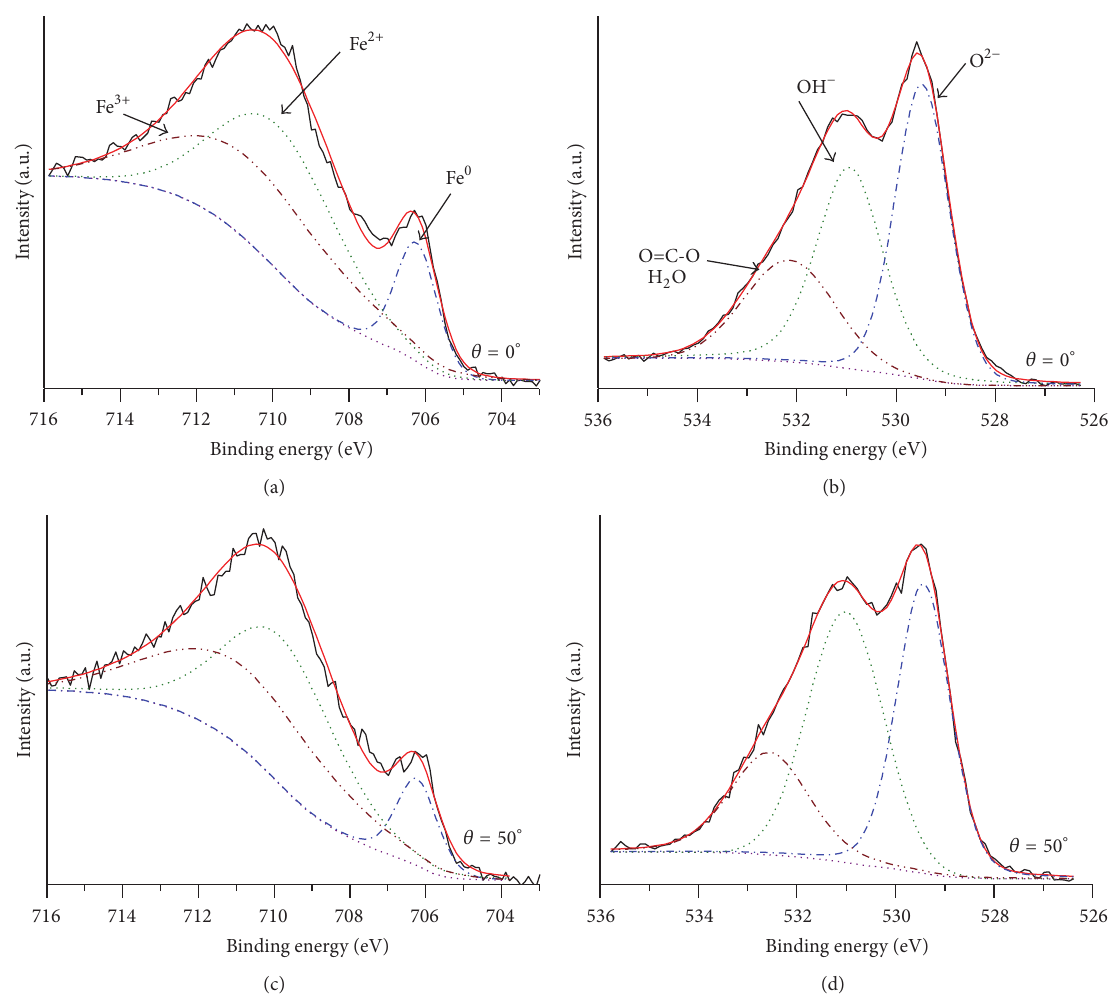
Figure 11: High resolution Fe 2p 3/2 and O 1s spectra for carbon steel after 2h immersion in 0.02 M NaCl containing 0.1M Na-glutarate; spectra obtained at a takeoff angle of 0 ∘ (a, b) and of 50 ∘ (c,